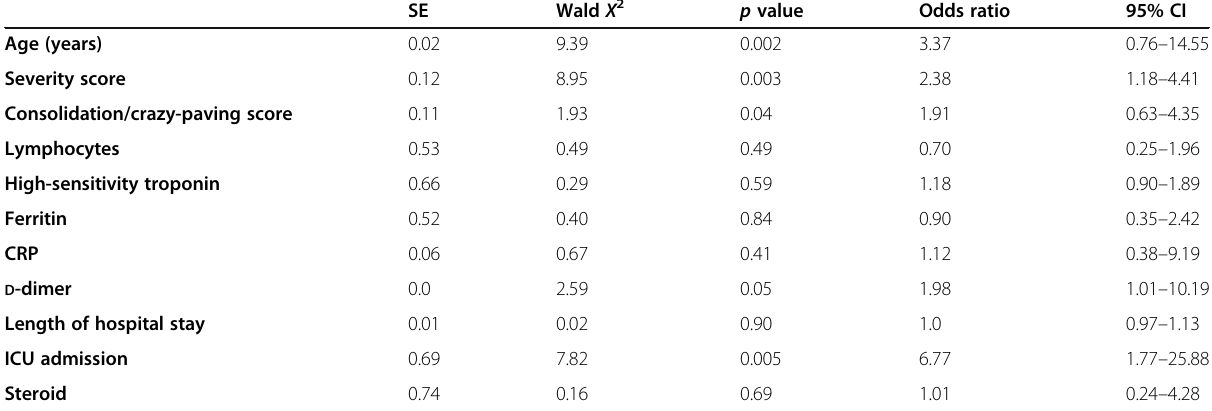
Table 4 Multivariate regression analysis for independent risk factors for prediction of post-COVID-19 fibrosis